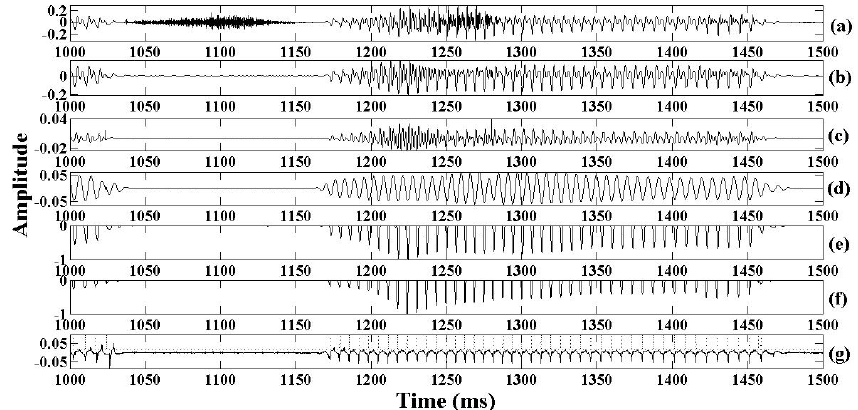
Figure 5. (a) Male speech signal segment. (b) LPF speech signal. (c) Derivative of LPF speech signal. (d) Fundamental harmonic component. (e) Extracted